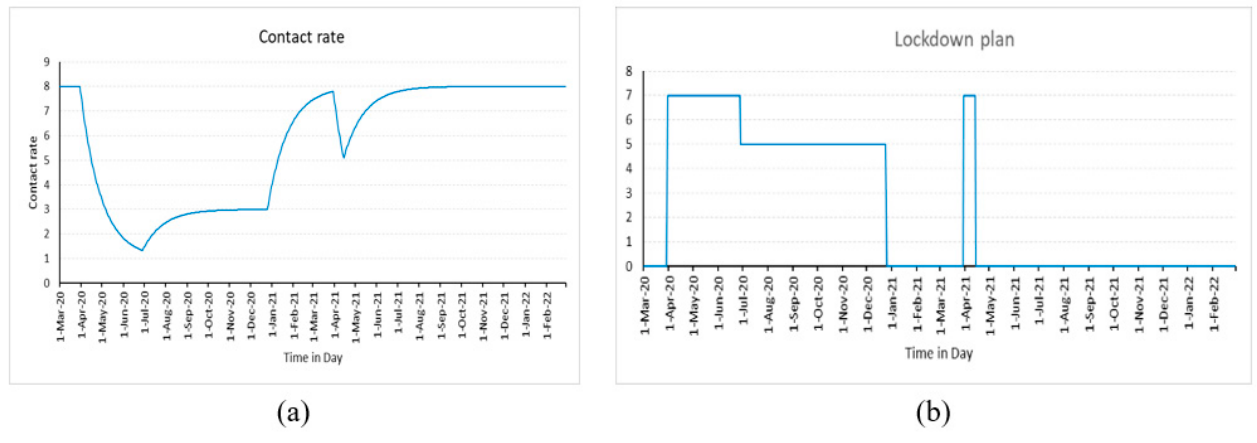
Figure 2. Behavior of ( a ) Contact rate; ( b ) Lockdown plan.